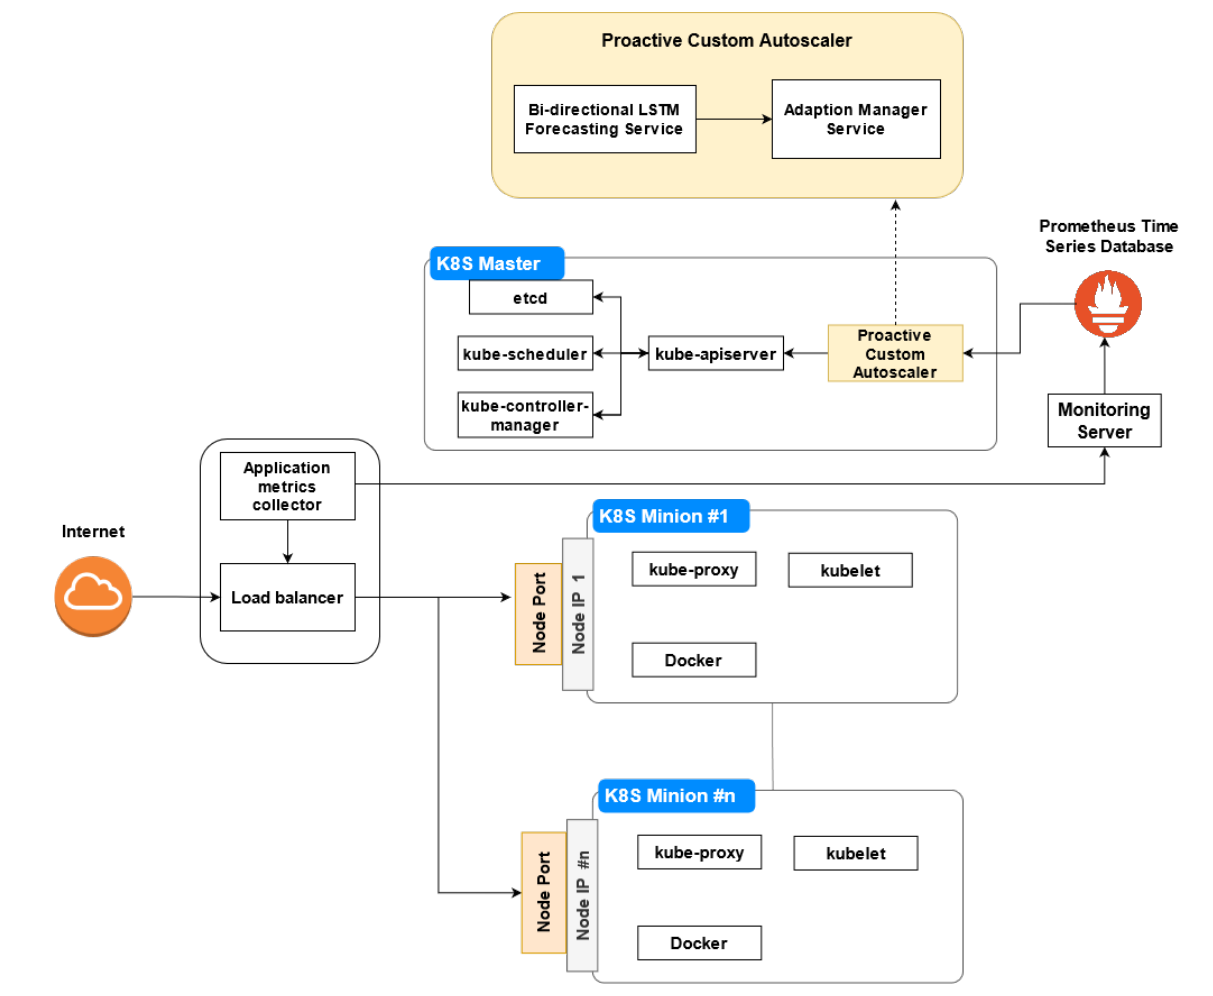
Figure 1. System